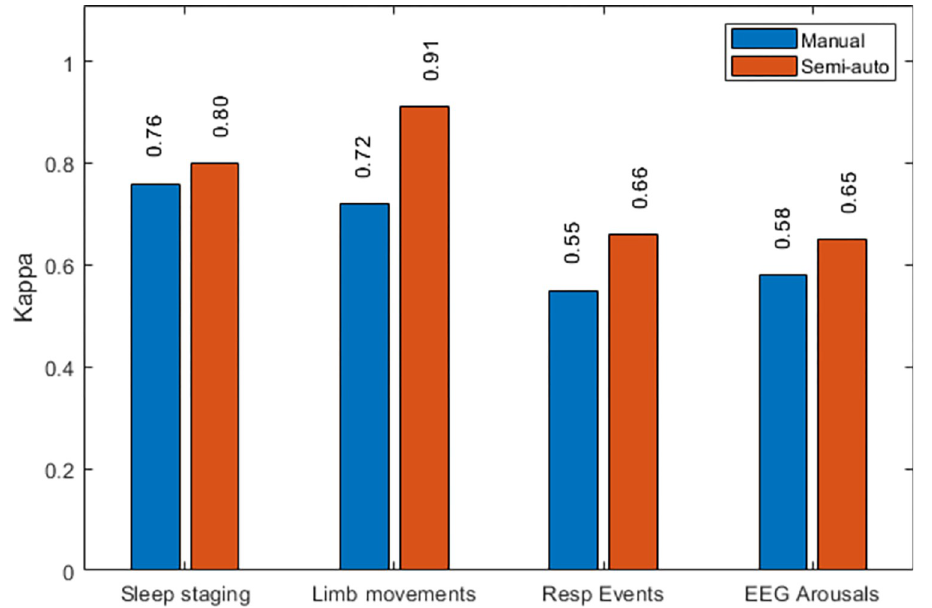
Fig 2. Agreement comparison between manual and semi-automatic scoring approaches. Median Kappa agreement for each task is shown by aggregating all the expert pair combinations throughout the five corresponding recordings.